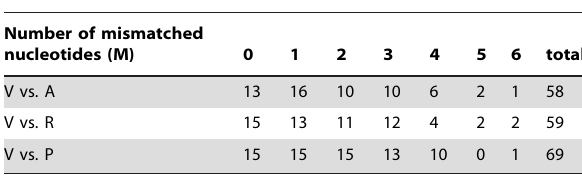
Table 2. Divergence of experimentally identified orthologous miRNA sequences in four plant